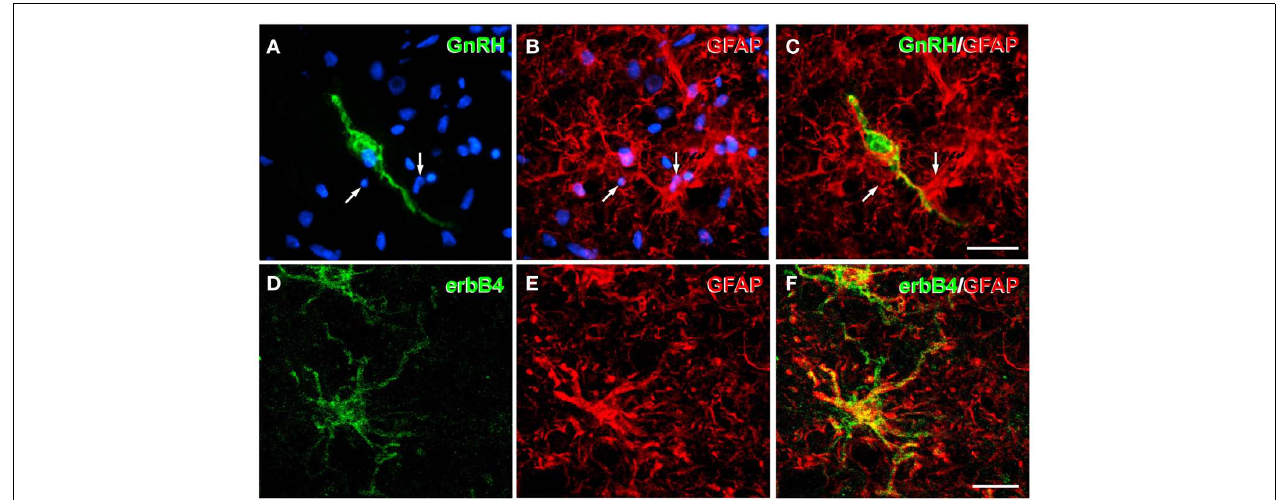
Cell nuclei are stained with Hoechst (blue). Adapted from (Baroncini et al., 2007) with permission. (D–F) GFAP-immunoreactive astrocytes (red) of the tuberal region of the human hypothalamus express erbB4 receptors (green; M. Baroncini andV. Prevot, unpublished data). Scale bars = 20 μ m (C) , 10 μ m (F)